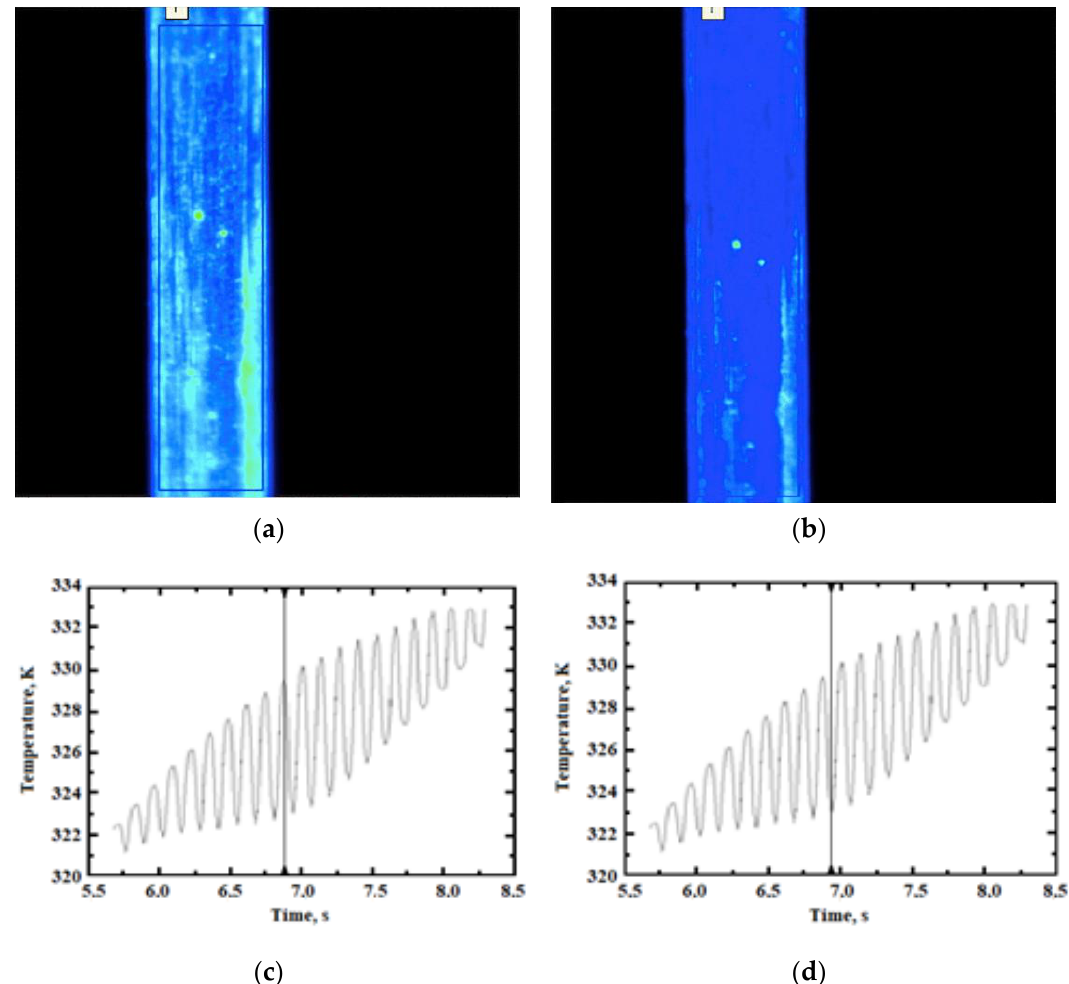
Figure 4. Thermograms of a polycrystalline tape made of Ti 2 NiCu alloy deformed at a frequency of 6 Hz: a — a tape under load, b — a tape without a load. Dependences of the sample temperature on time ( c ) and ( d ) at the time point corresponding to the recording of thermograms ( a ) and ( b ), respectively.